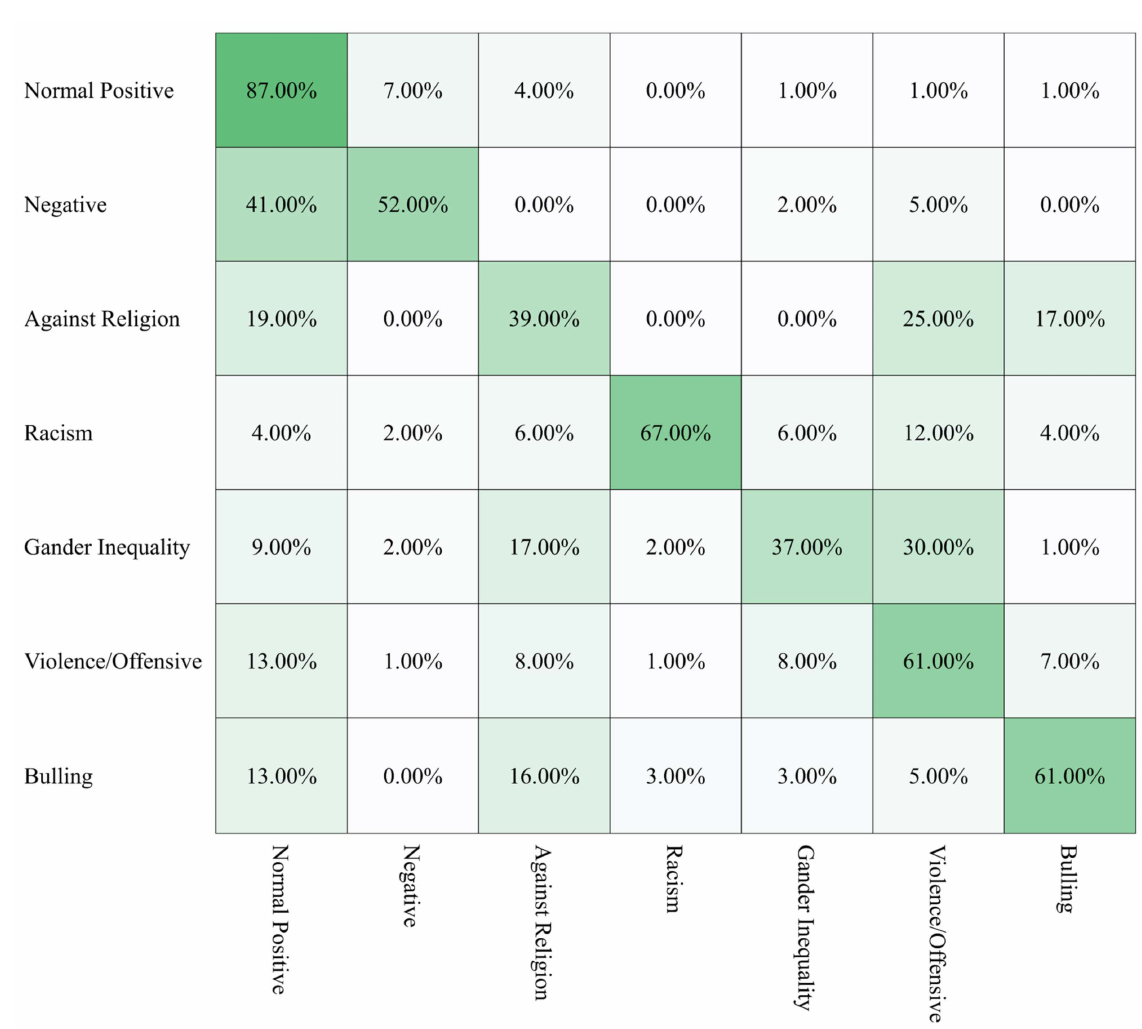
Figure 6. Confusion matrix of the experimental results from the proposed deep recurrent neural network model-based classification method for seven classes of Arabic